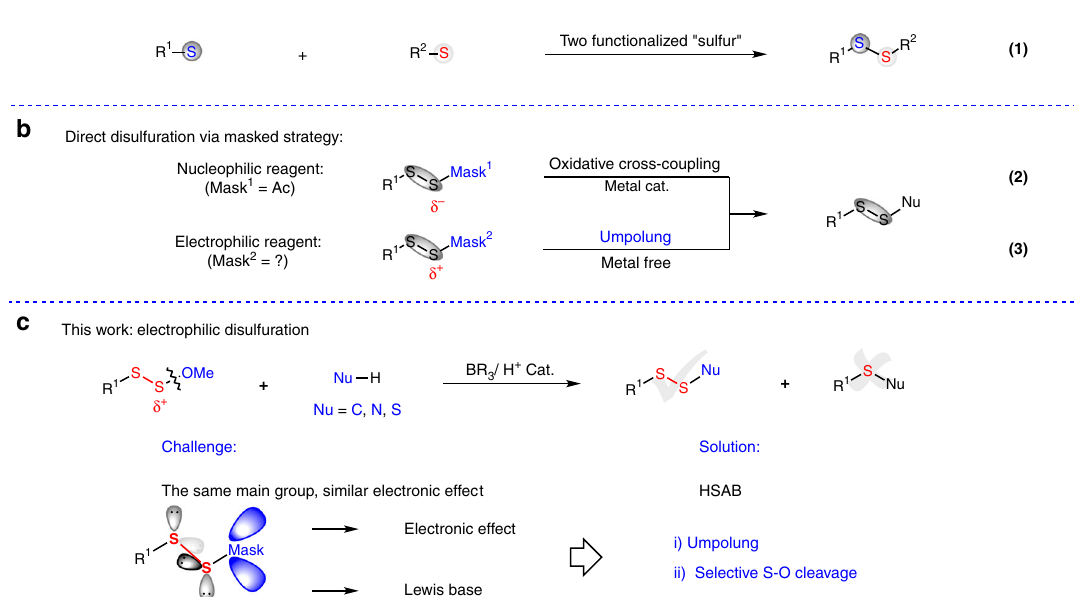
Fig. 2 Strategies for polysul fi de construction. a Traditional methodologies for unsymmetrical disul fi de syntheses. b Masked strategy for disulfuration. c Electropilic disulfurating reagent for